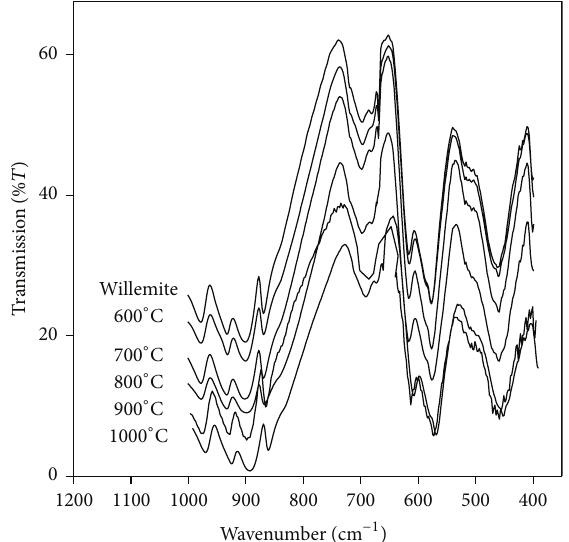
Figure 5: FTIR spectra of pure willemite and Eu 2 O 3 doped willemite samples sintered at various temperatures and doped with different weight percentages of Eu 3+ .